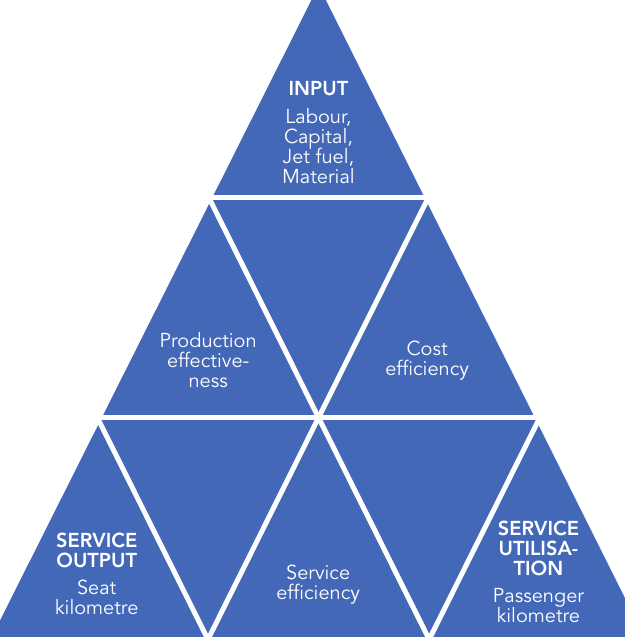
Figure 1: Framework of